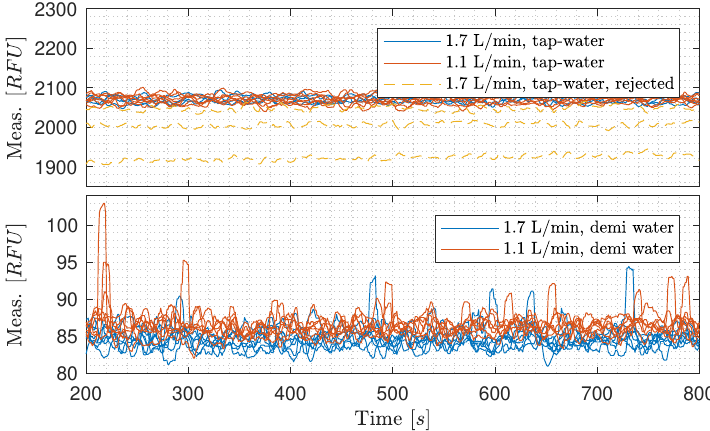
Figure 11. Repeatability investigation of flow-dependency on C 1 with demineralized water and tap water at two different flow